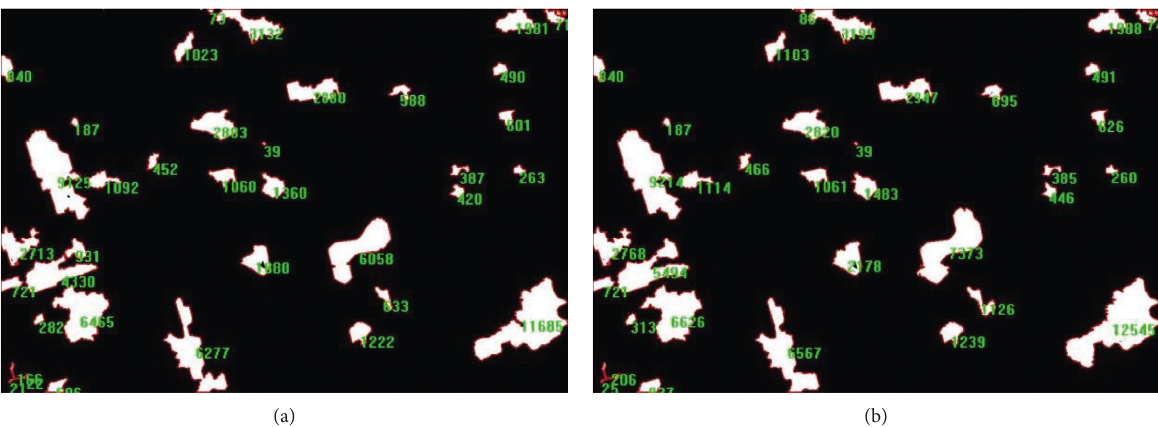
Figure 9: Comparisons of air void size of the RH-WMA before and after freeze-thaw cycles. (a) The air void size before freeze-thaw cycles. (b) The air void size after freeze-thaw